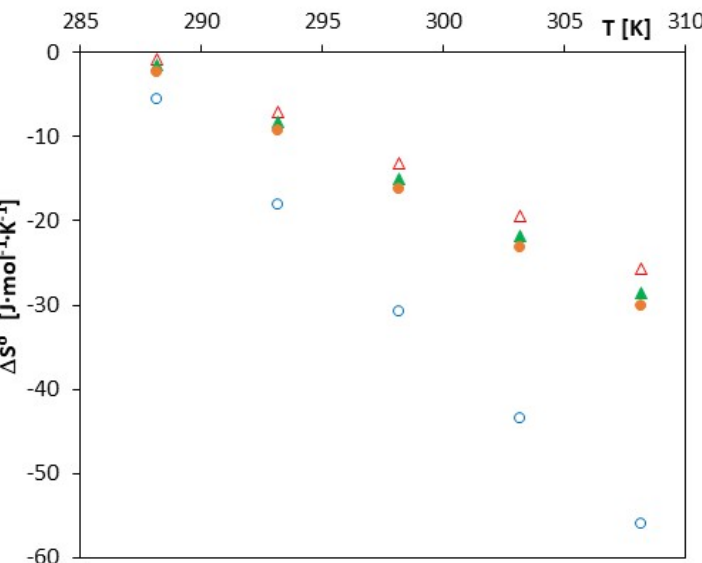
Figure 5. The plots of dependence of ∆ H o (J · mol − 1 ) in the function T (K) for α -cyclodextrin with all studied salts: ∆ - trans -cinnamic acid; ▲ - trans-p -coumaric acid; ● - trans -caffeic acid; and ○ - trans -ferulic acid.